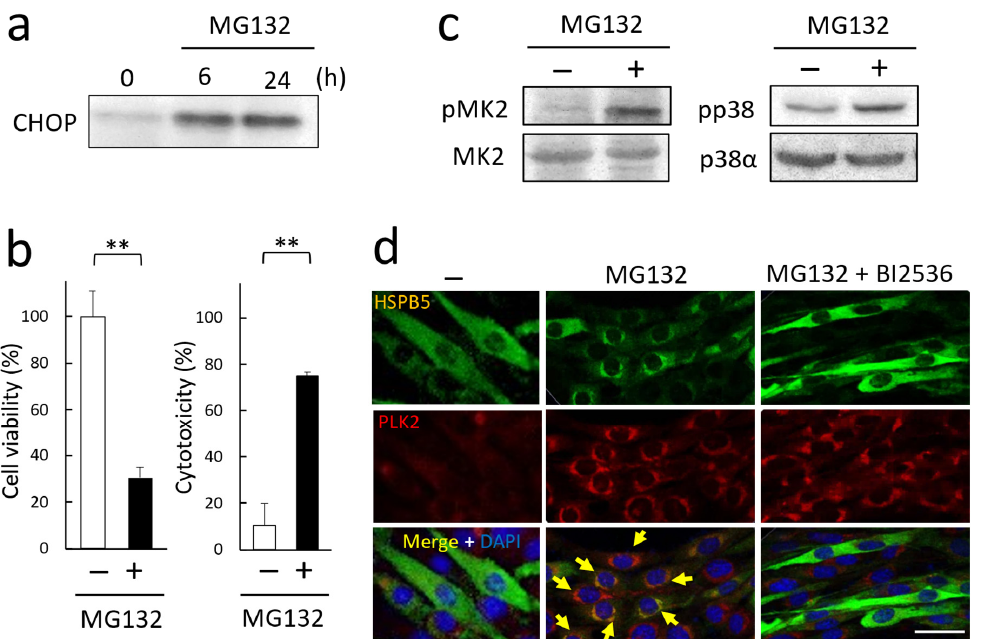
Figure 4. MG132 induced ER stress in L6 cells. ( a ) Induction of ER stress by MG132. After differentiation (48 h), L6 myotubes were treated with 5 µ M MG132. Induction of CHOP expression was detected by Western blotting. ( b ) Effect of MG132 treatment on cell viability and cytotoxicity of L6 cells. After differentiation, L6 myotubes were treated with 5 µ M MG132 (24 h). Cytotoxicity was measured from activity of lactate dehydrogenase in the medium. Data in graphs represent means ± standard error (n = 3). Statistical analyses were performed using t -test. ** p < 0.01. ( c ) Activation of stress-related kinases by MG132 treatment. After 5 µ M MG132 treatment (24 h), phosphorylation of MK2